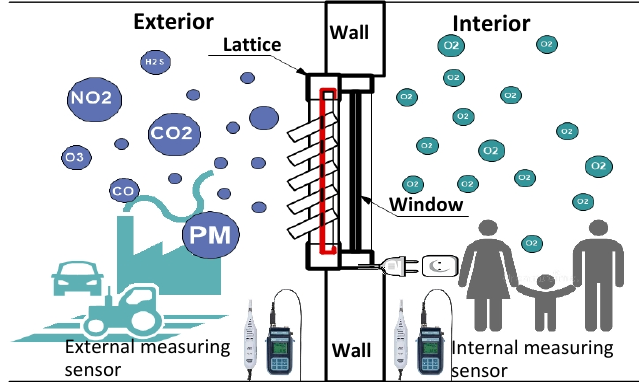
Figure 13. Schematization of measurements.